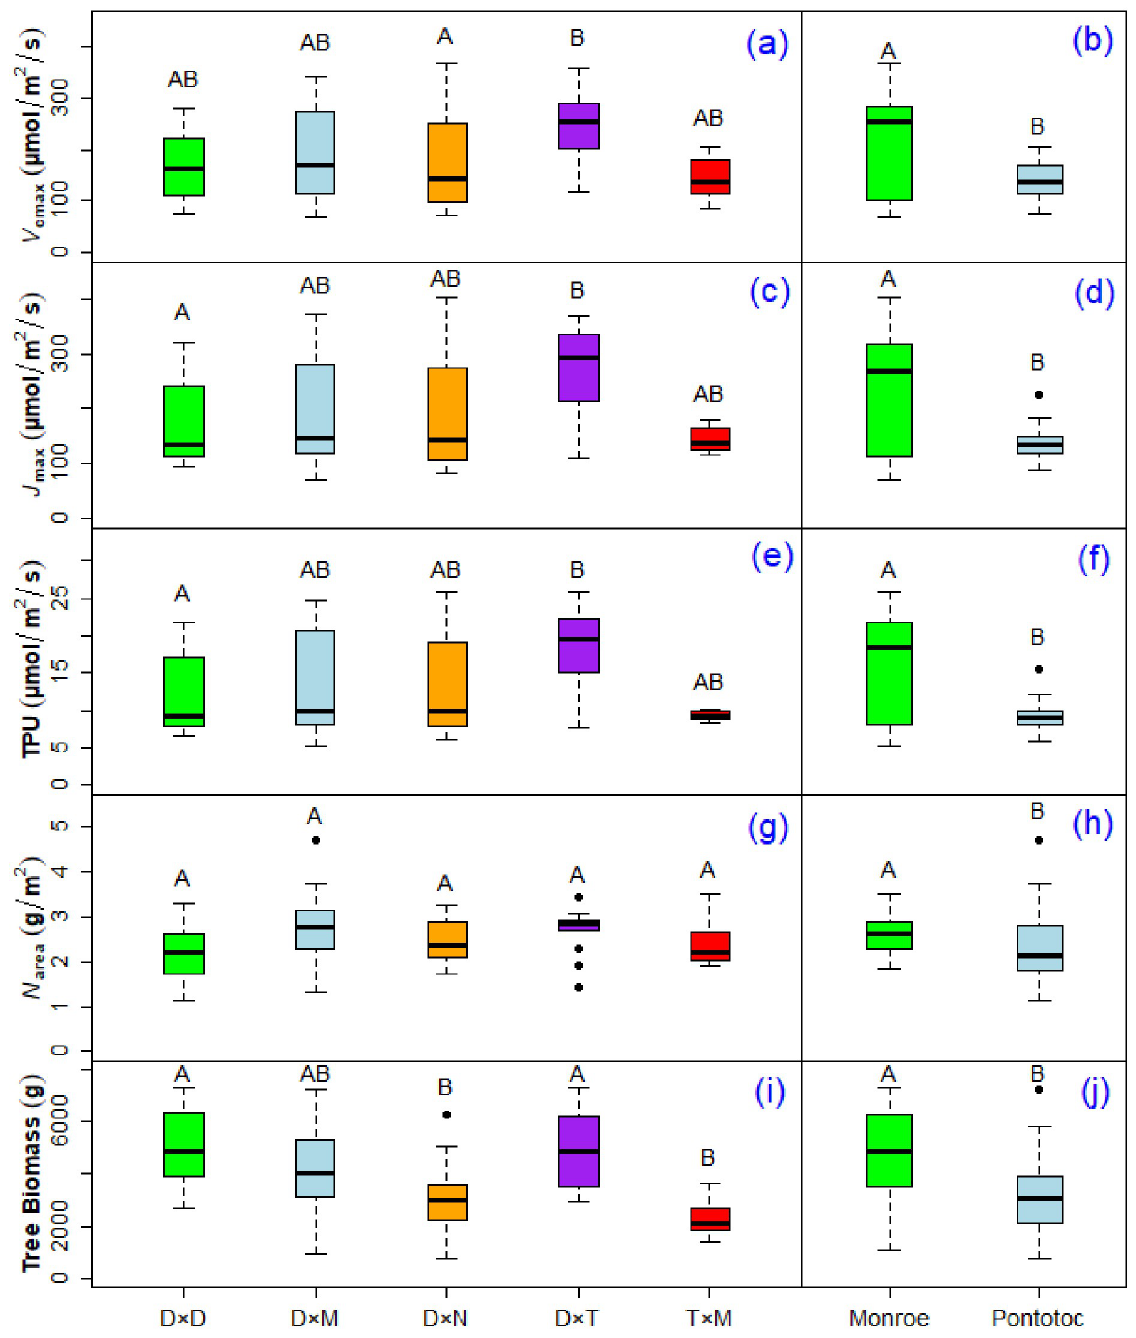
Fig 1. Box plots showing the variability among five different Populus taxa (left panels) and between the Monroe and Pontotoc sites (right panels). Bars with different letters indicate statistically significant differences ( P -value < 0.05). Parameters include maximum carboxylation rate of Rubisco ( V cmax ) by (a) taxa and (b) site, maximum electron transport limited carboxylation rate ( J max ) by (c) taxa and (d) site, triose phosphate utilization limited carboxylation rate (TPU) by (e) taxa and (f) site, nitrogen per unit leaf area ( N area ) by (g) taxa, (h) site, and tree biomass by (i) taxa and (j) site. D × T and T × D taxa were combined and shown as D × T, and (D × N) × M was included in D × N (S1 Table). D × D = P . deltoides × P . deltoides , D × M = P . deltoides × P . maximowiczii , D × N = P . deltoides × P . nigra , D × N × M= P . deltoides × P . nigra × P . maximowiczii , D × T = P . deltoides × P . trichocarpa , T × D = P . trichocarpa × P . deltoides , and T × M = P . trichocarpa × P . maximowiczii .